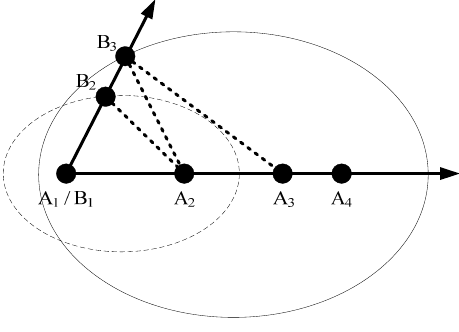
Figure 3. Novel definition of opposite path (Backward